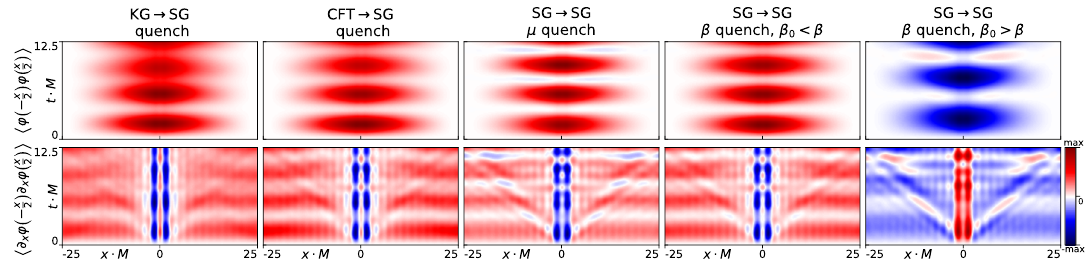
Figure 5 . Density plots of correlation dynamics for di(cid:11)erent types of quenches: from the KG ground state, the massless free boson (CFT) ground state, SG mass (cid:22) quench, SG interaction quench from smaller to larger interaction (cid:12) or vice versa. Plots are for Dirichlet boundary conditions where it is technically easier to perform a TCSA simulation for all these di(cid:11)erent types of quench. many vacua characterised by the topological charge (a.k.a. winding number), and solitons interpolating between them appear as the fundamental topologically charged